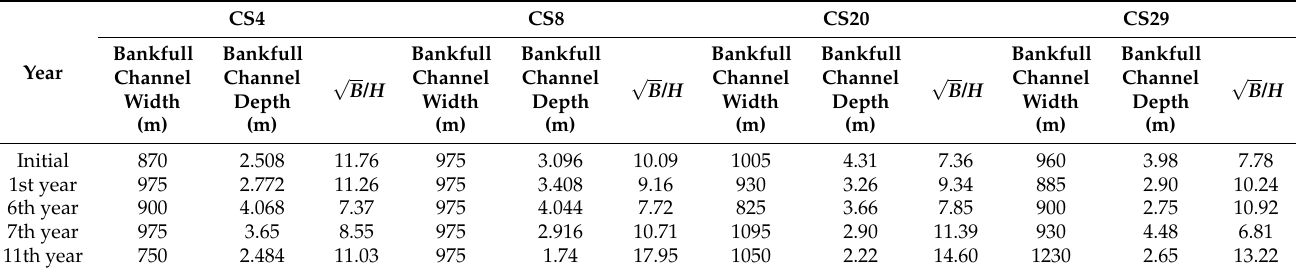
Table 5. Statistics of the bend section shape parameters constrained by nine projects.